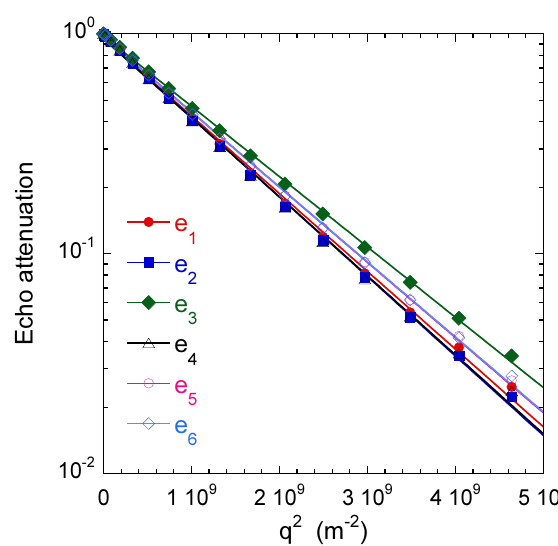
Figure 14. Water self-diffusion propagators measured within the saturated clay sample. More details on the selected diffusion directors (cid:126) e i are given (see text above), leading to the components of the self- diffusion tensor D 1 = 1.041 × 10 − 9 m 2 /s, D 2 = 1.062 × 10 − 9 m 2 /s, D 3 = 0.918 × 10 − 9 m 2 /s, D 4 = 1.067 × 10 − 9 m 2 /s, D 5 = 0.991 × 10 − 9 m 2 /s, and D 6 = 0.992 × 10 − 9 m 2 /s. Reprinted